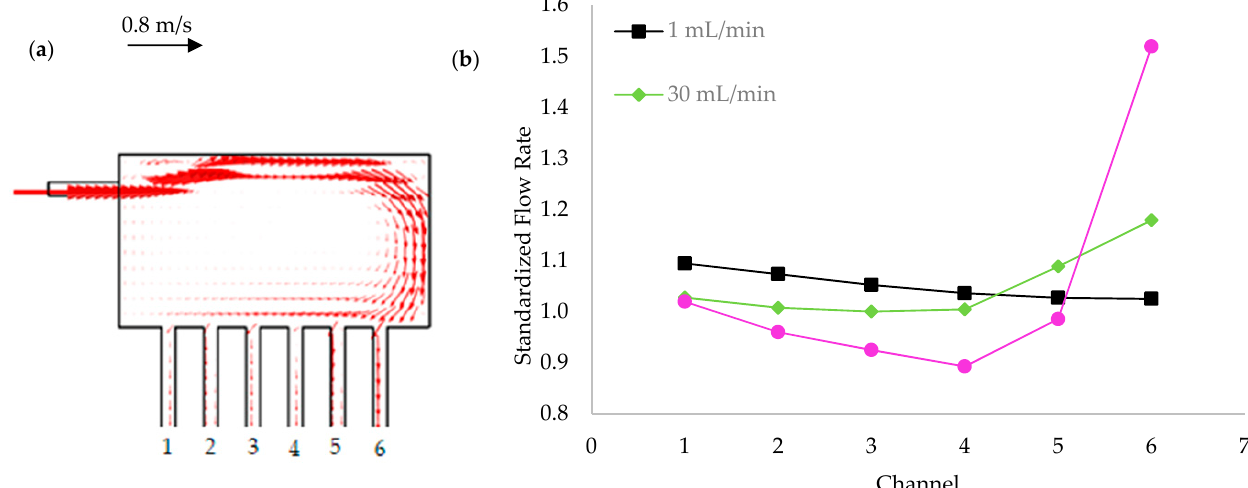
Figure 13. FDU study for the inverted horizontal configuration. ( a ) Schematic view of the velocity profile for a 100 mL/min flow and at a scale of 2. ( b ) The standardized flow in each channel of the heat sink. The vertical configuration presented the best results, since the placement of the inlet vertically allows it to be perpendicular to the smallest dimension of the collector (height of 1 mm). In this way, the jet is immediately broken and spread radially. This phenomenon is known as jet impingement [31], and is shown in Figure 14. It is responsible for the uniformity in this configuration, where no preferential flow path is